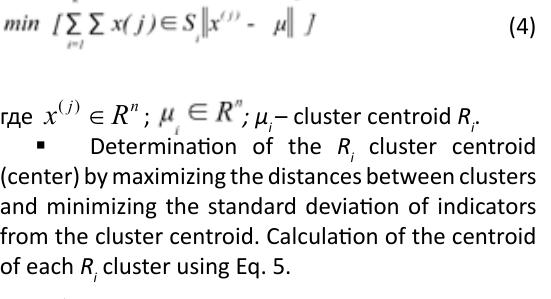
§ Matrix transformation (7) to a dimensionless standardized form and matrix standard formation, Where, 0 is the best value in columns using Eq. 8. Determination of the multidimensional Euclidean distance from the matrix standard using Eq. 9.